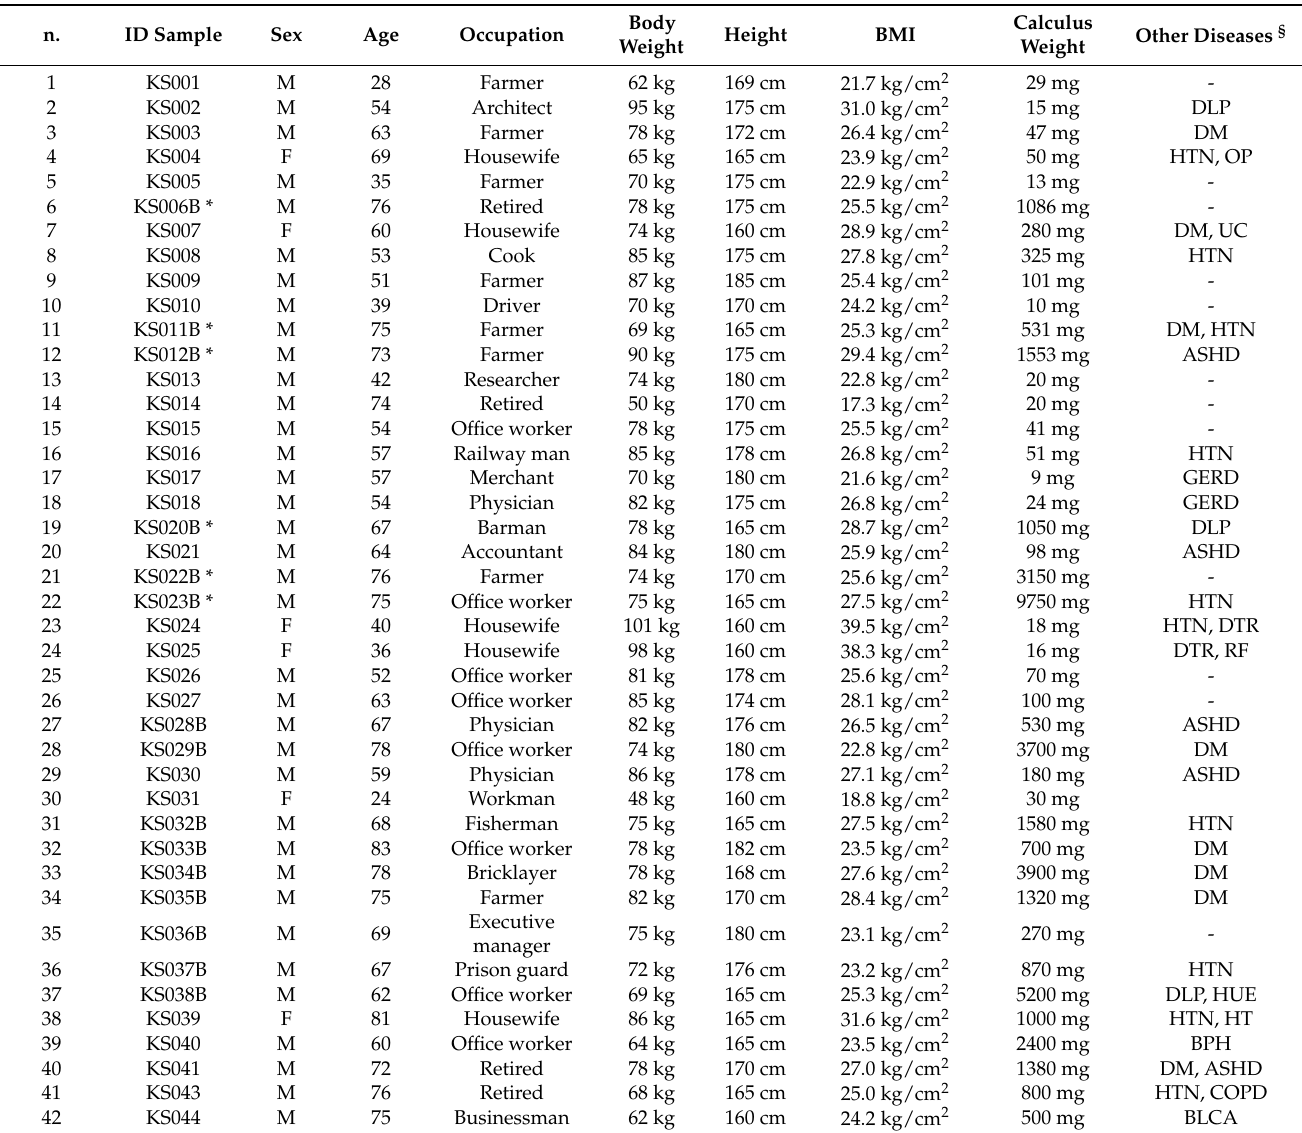
Table 1. Patient’s personal details. M, male; F female; Age expressed in years; BMI, body mass index; * from